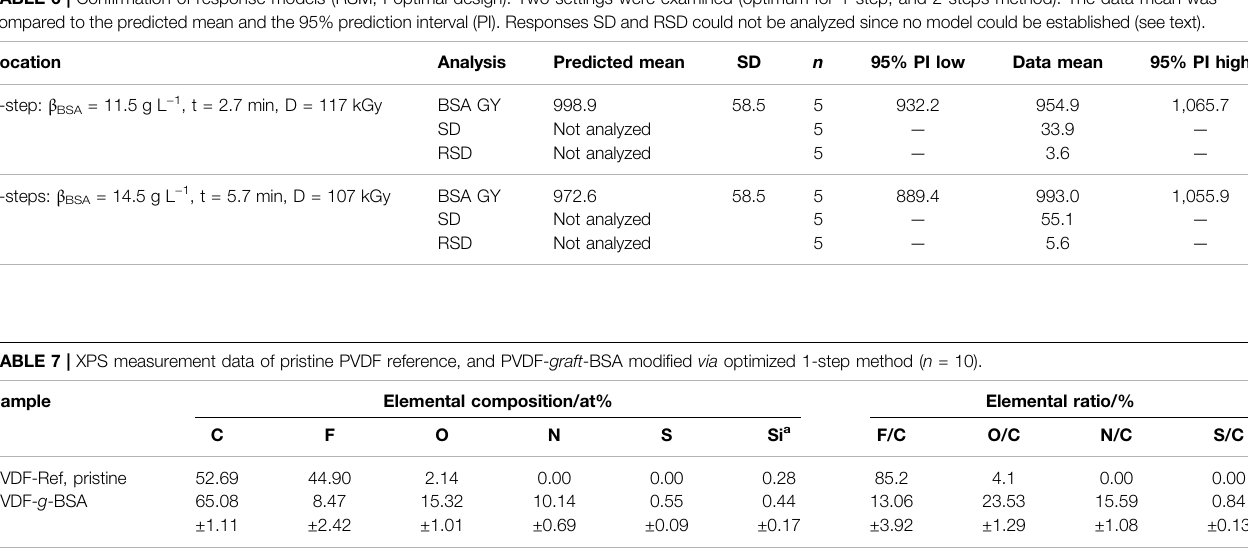
PVDF-Ref, pristine